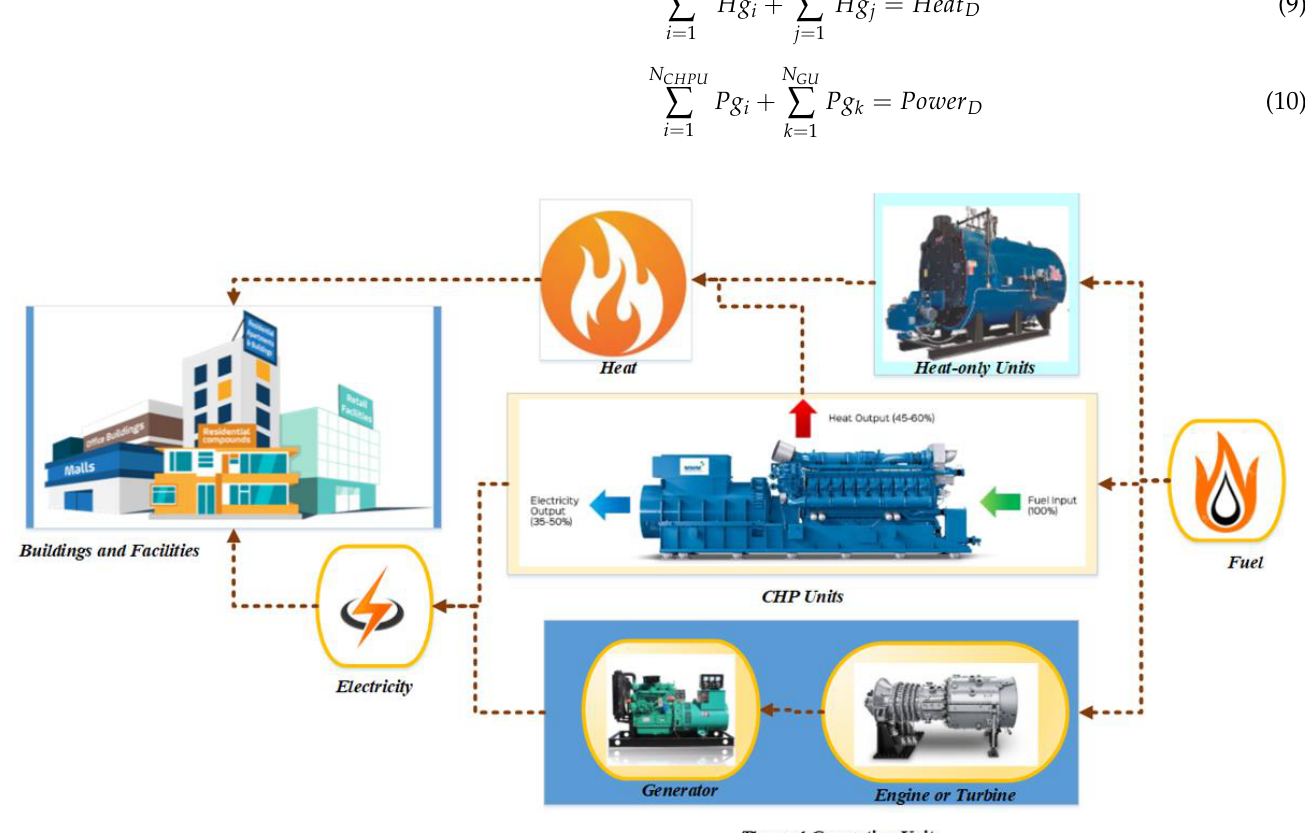
Figure 1. Key players in the ED problem with CHPUs [35].